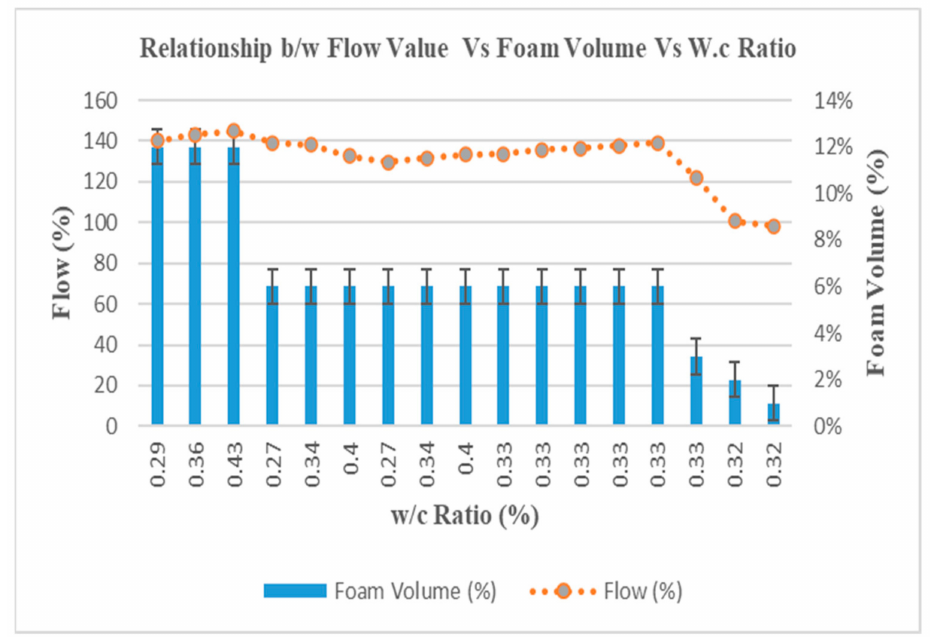
Figure 7. Flow vs. Foam Volume vs. w / c Ratio of